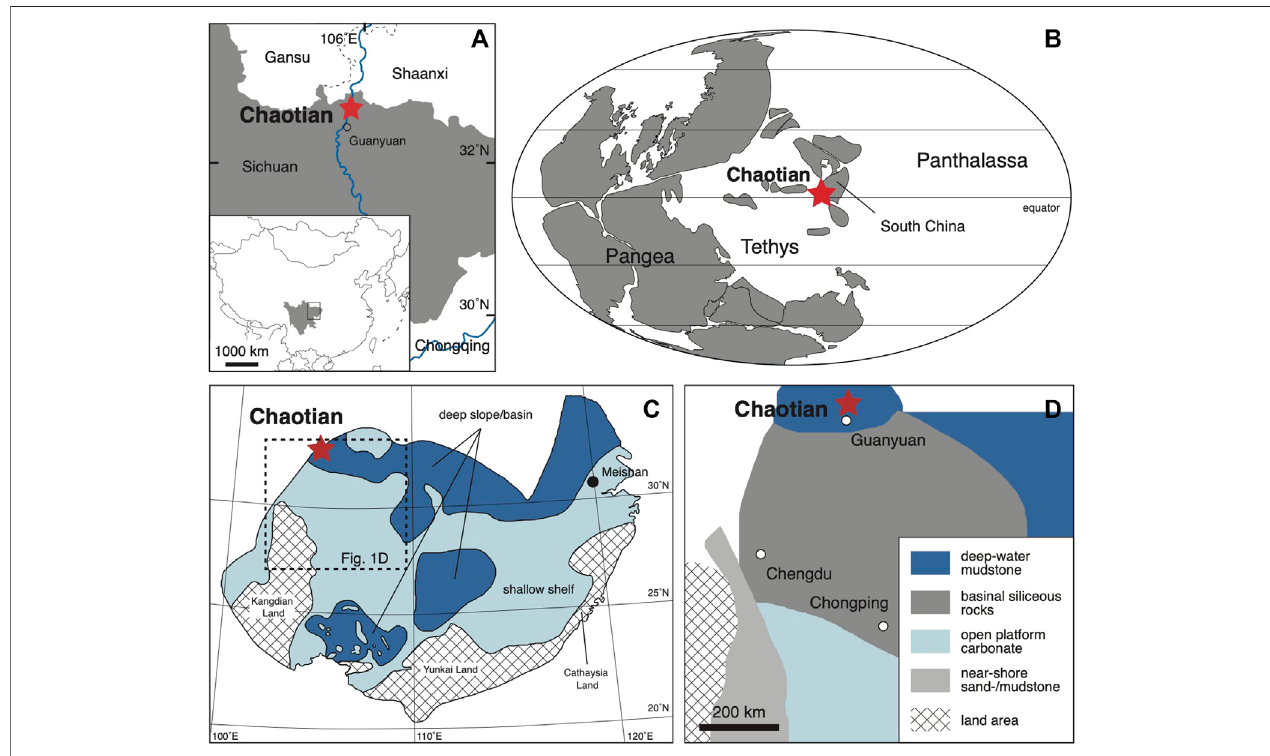
FIGURE 1 | Locality and paleogeographic maps of Chaotian. (A) Location map of Chaotian. (B) Global paleogeographic map around the P-TB (modi fi ed from Muttoni et al., 2009). (C) Sedimentary facies distribution in South China in the late Changhsingian (late Late Permian) (modi fi ed from Wang and Jin, 2000). (D) Detailed sedimentary facies in the square in C (modi fi ed from Zhu et al.,